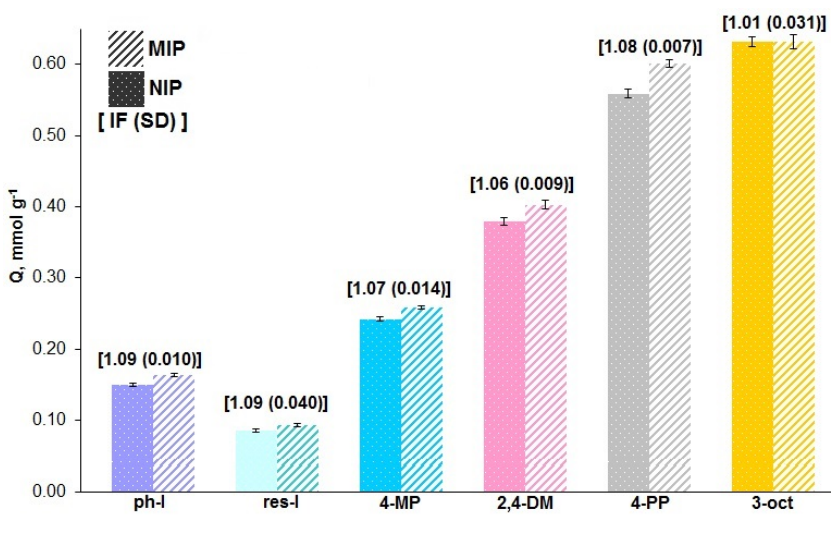
C (adsorbate) = 1.594 mM. Note: IF is an average of ratios of Q i